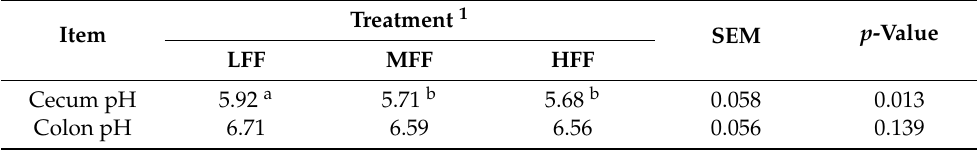
Table 4. Digesta pH at days post inoculation 42 of pigs inoculated with Brachyspira hyodysenteriae and fed a lowly fermentable diet (LFF), an intermediate fermentability diet (MFF), and a highly fermentable diet (HFF).